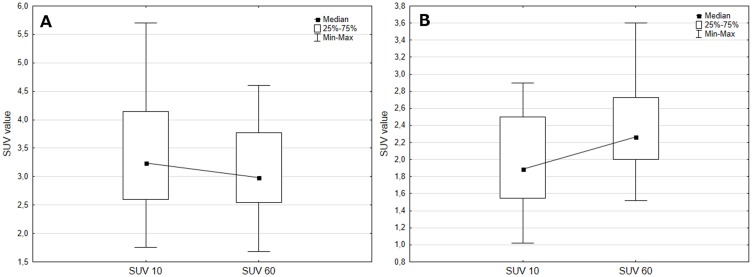
SUV kinetics for high (left graph) and low (right graph) grade gliomas.